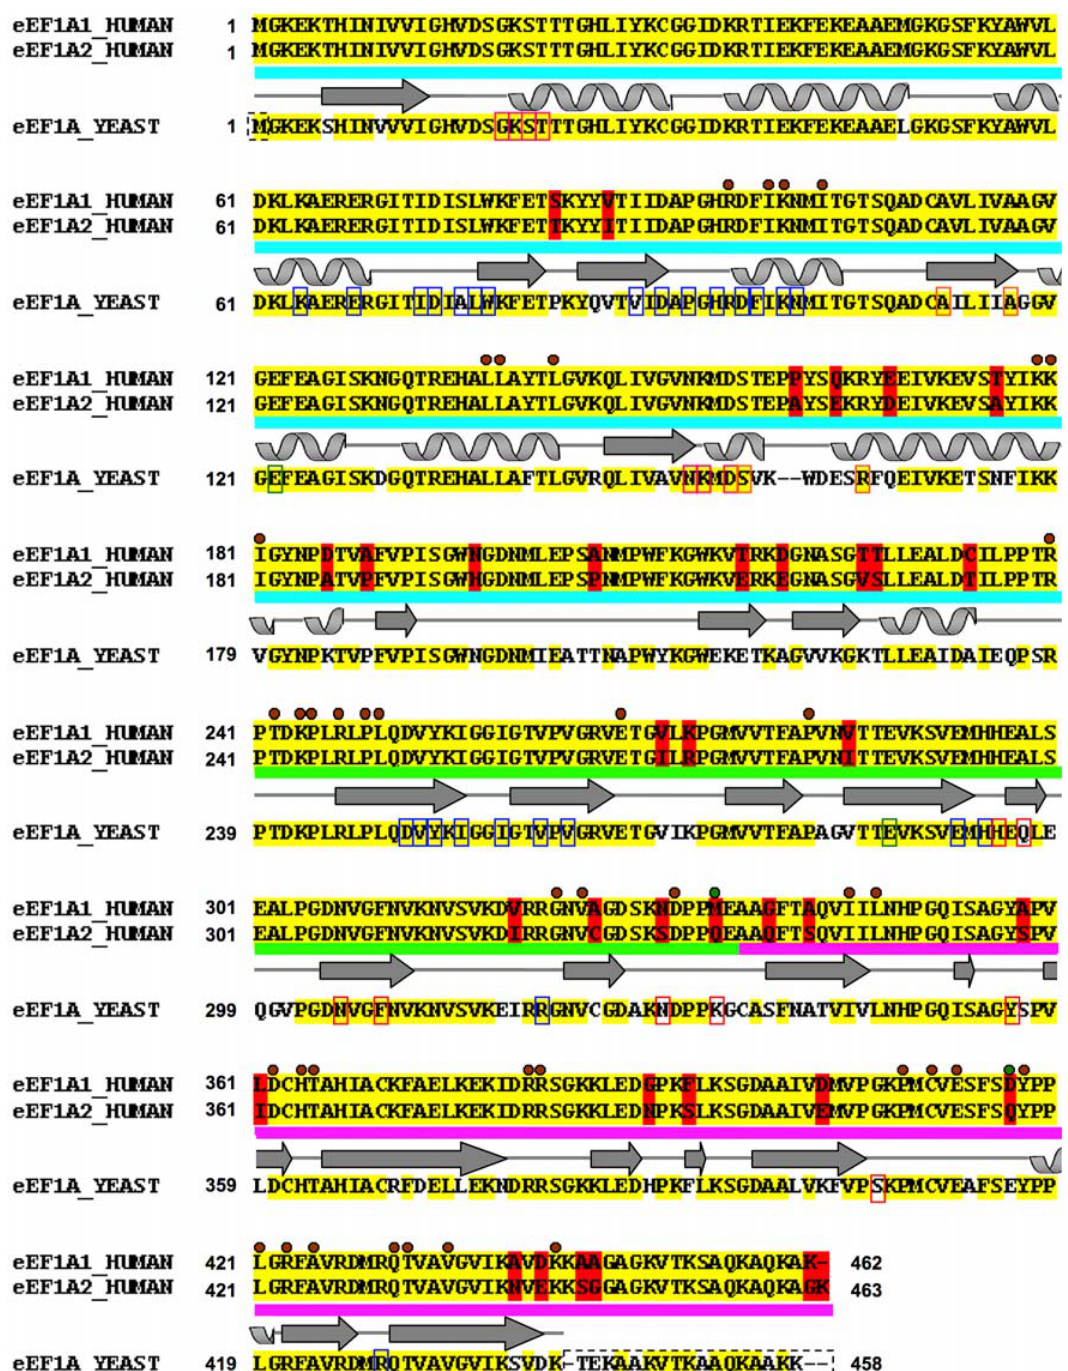
Figure 1. Sequence alignment between human eEF1A1 and eEF1A2 and yeast template. The pair-wise sequence alignment between human eEF1A1 and eEF1A2 is shown: identical residues (yellow background), variant residues (red background). The aligned yeast eEF1A template is shown below with identical residues to the human sequences highlighted (yellow background) and any variant position between yeast and either human sequence shown with a white background. The two human sequences share 92% sequence identity with each other and each show , 81% sequence identity with the yeast protein. The domain boundaries (domain I: cyan; domain II: green; domain III: pink), and STRIDE [44] secondary structure assignment is traced above the yeast template sequence (arrows=beta-strands; coils=alpha-helices). The amino acid residues involved in domain-domain contacts are indicated with a brown circle (green circle for non-identical equivalent residues between two human variants); those involved in the binding of C-terminal fragment eEF1B a are indicated on the yeast sequence with blue rectangles; residues involved in GDP-binding indicated in pink rectangles; and those disordered in the yeast crystal structure are indicated with a dashed rectangle. Yeast mutagenesis data and motifs are highlighted on its sequence: mutations involved in actin bundling/disorganization (red rectangles) [70,71]; mutations that affect translational fidelity (green rectangles) [77]; mutations that reduce dependence on eEF1B (orange rectangles) [78,79].